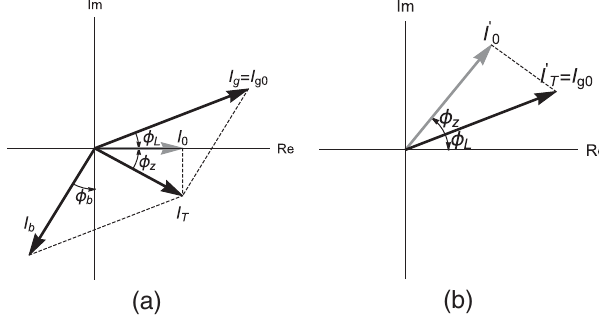
FIG. 38. (a) Steady state phasor diagram under beam loading and (b) phasor diagram just after the beam extraction.